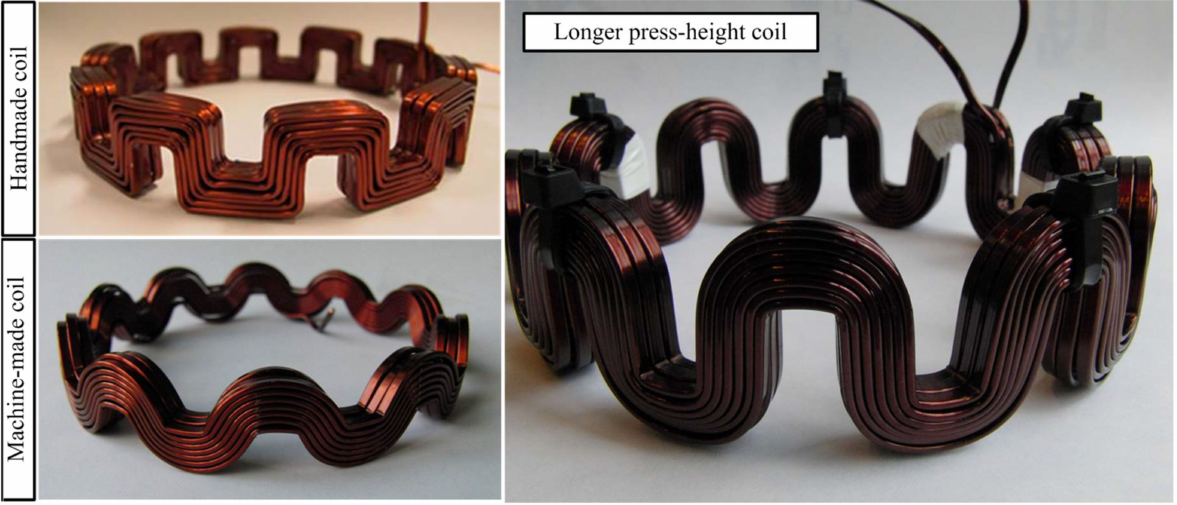
Figure 27. Wave-windings shaped in a ring of rectangular copper wires for a powder-core claw pole machine [103].